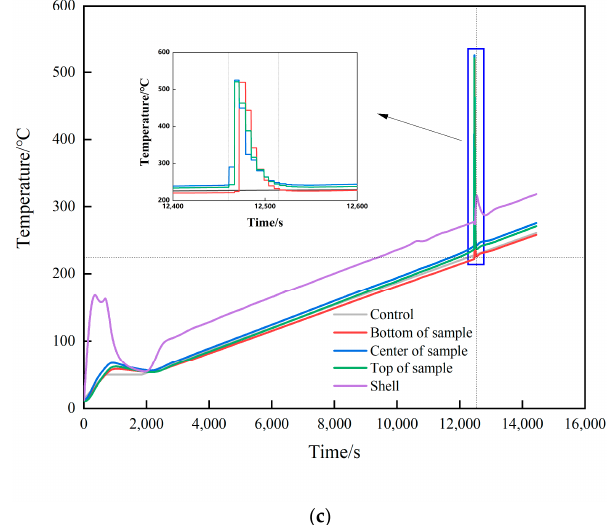
Figure 4. Temperature–time curve. ( a ) 7 °C/min. ( b ) 1 °C/min (no temperature preservation). ( c ) 1 °C/min (temperature preservation for 20 min).